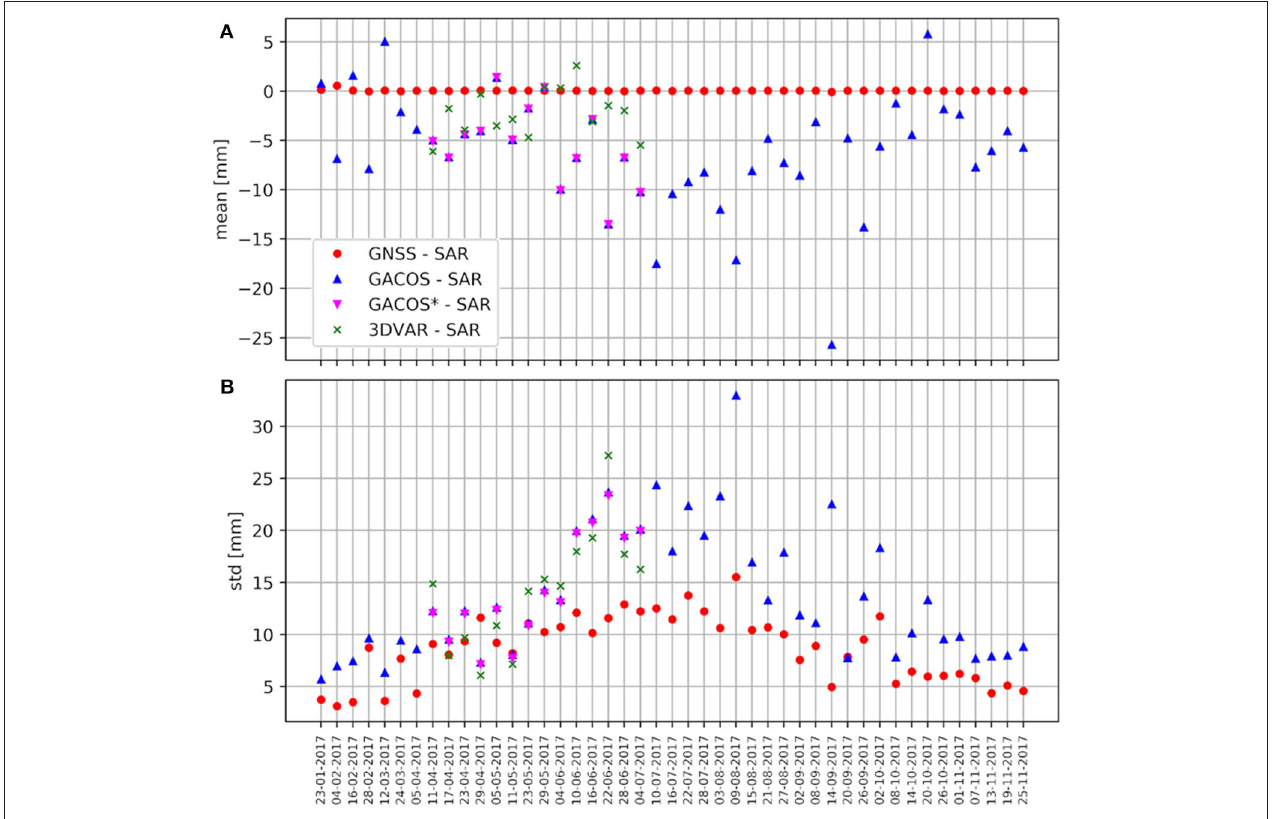
FIGURE 4 | Time series of the spatial statistics of GNSS-SAR and model-SAR 1 ZTD differences: mean values in (A) and standard deviation in (B)